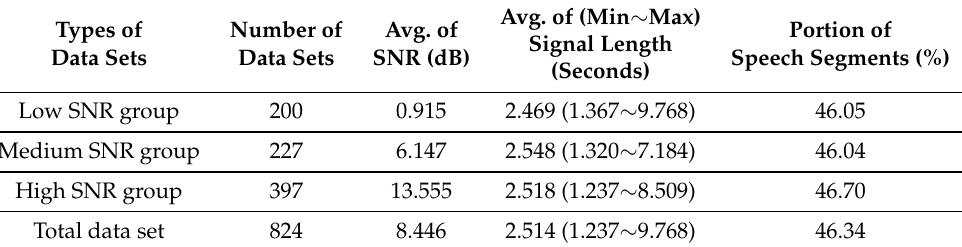
Table 1. The characteristics of the used data